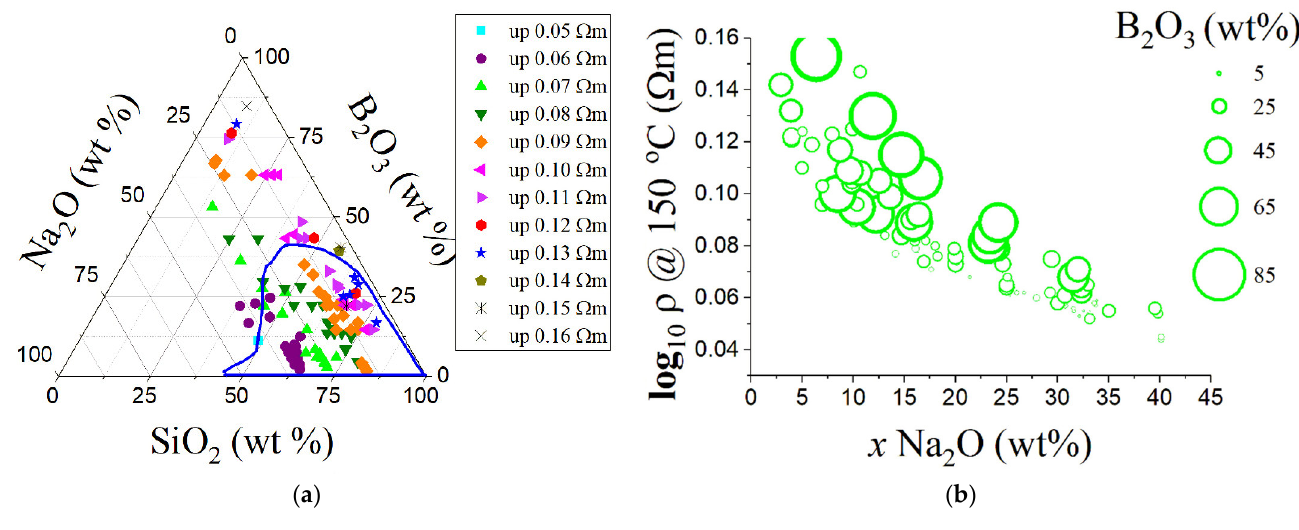
Figure 8. ( a ) Ternary diagram of selected sodium borosilicate glasses from Sciglass TM database (version 7.9). The blue region corresponds to approximately the logarithm of resistivity behavior at 150 °C from a plethora of sodium borosilicate waste-immobilization glasses. ( b ) The resistivity dependence on sodium oxide content at 150 °C. Resistivity decreases with the increasing sodium oxide content, and for a fixed sodium oxide content, resistivity in general also decreases with the decreasing boron oxide content.